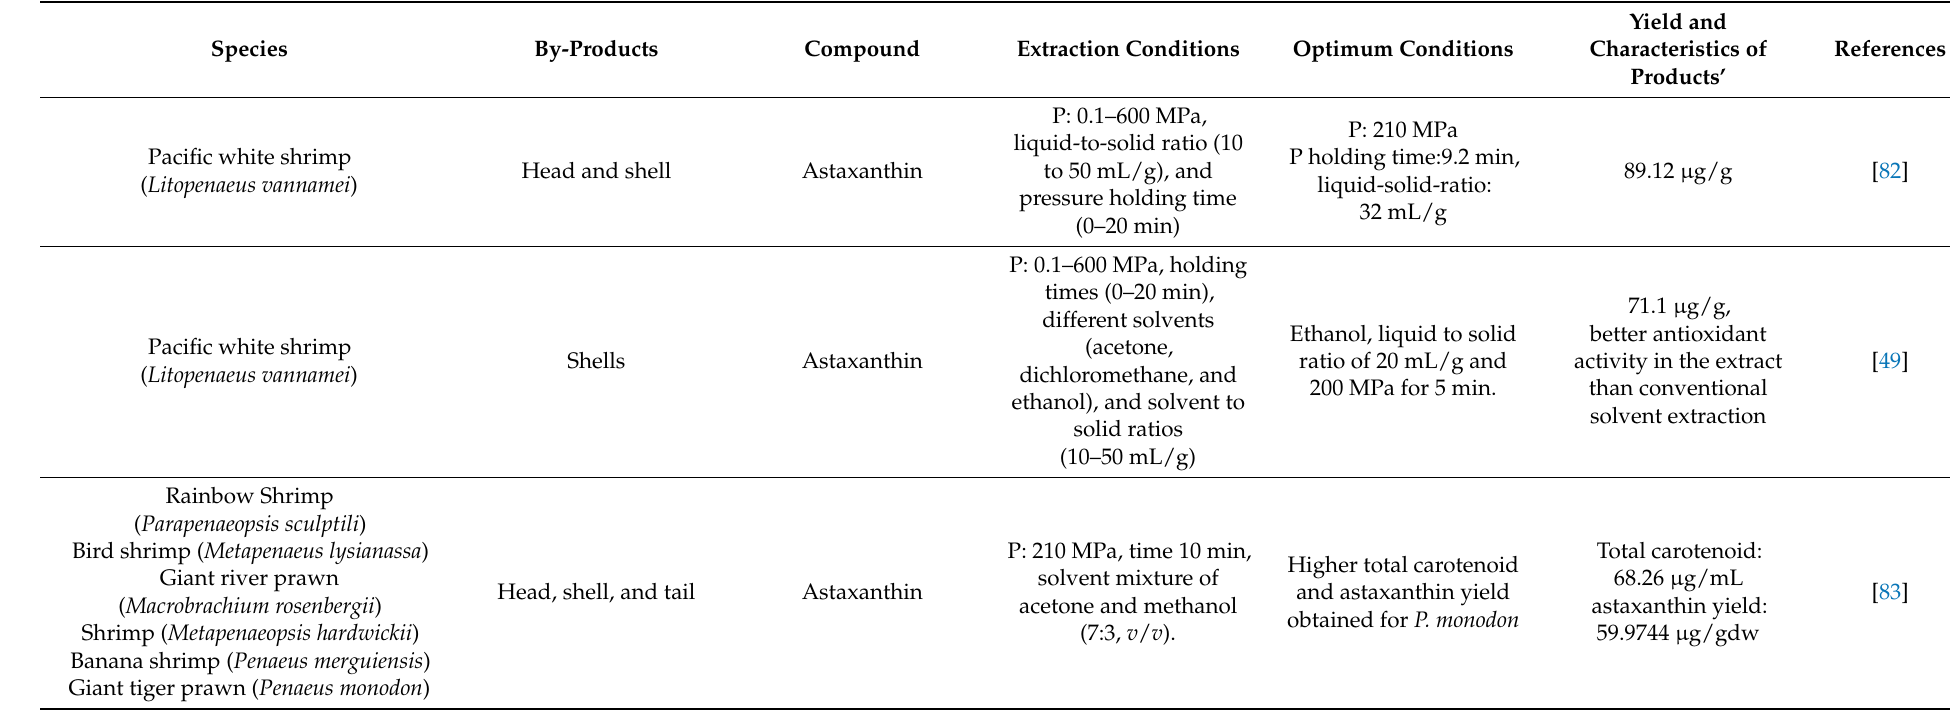
Table 2. High-pressure extraction (HPE) of crustacean by-products for the recovery of valuable